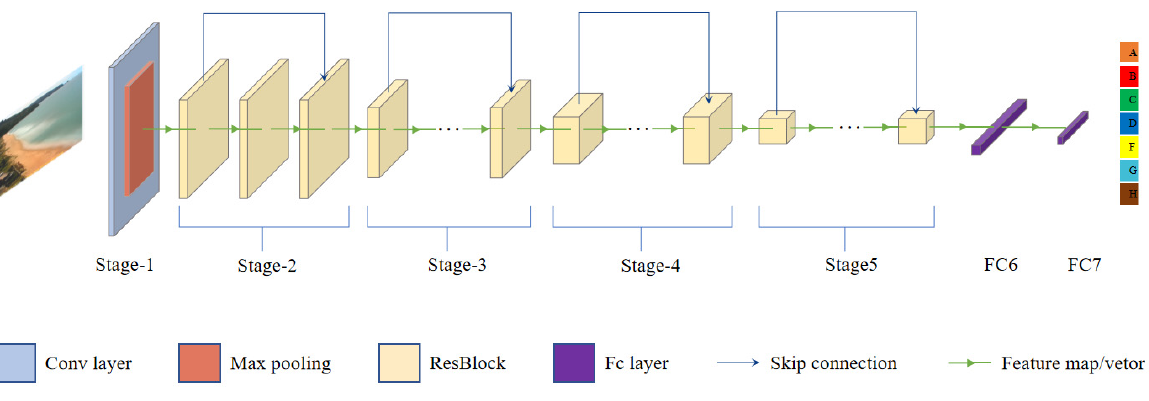
Figure 2. Model Figure 2. Model structure.